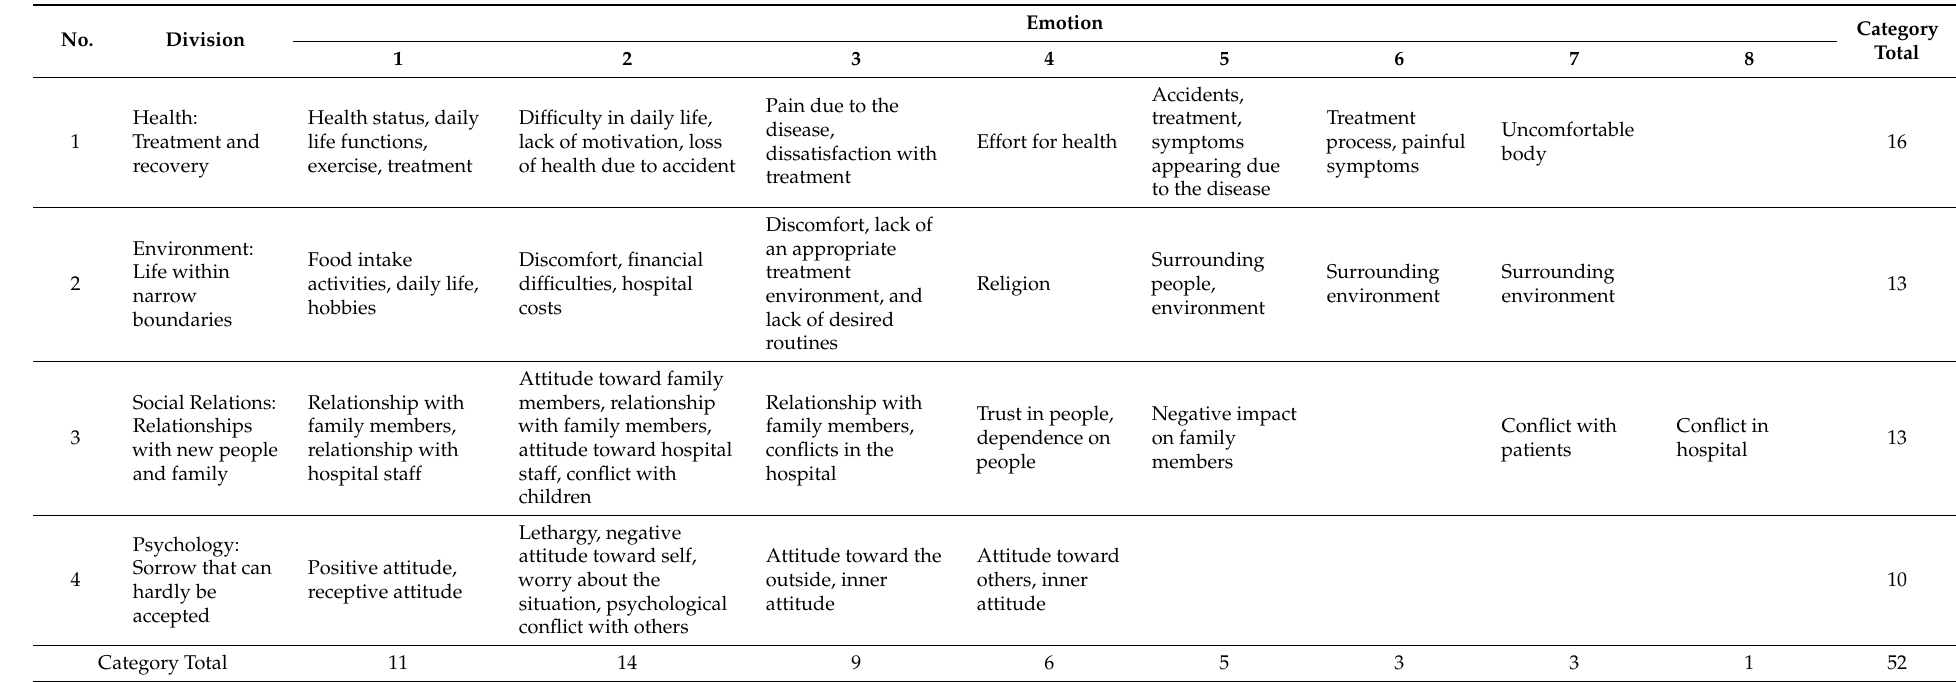
Table 3. Four dimensions by emotion type of senior patients and categories by